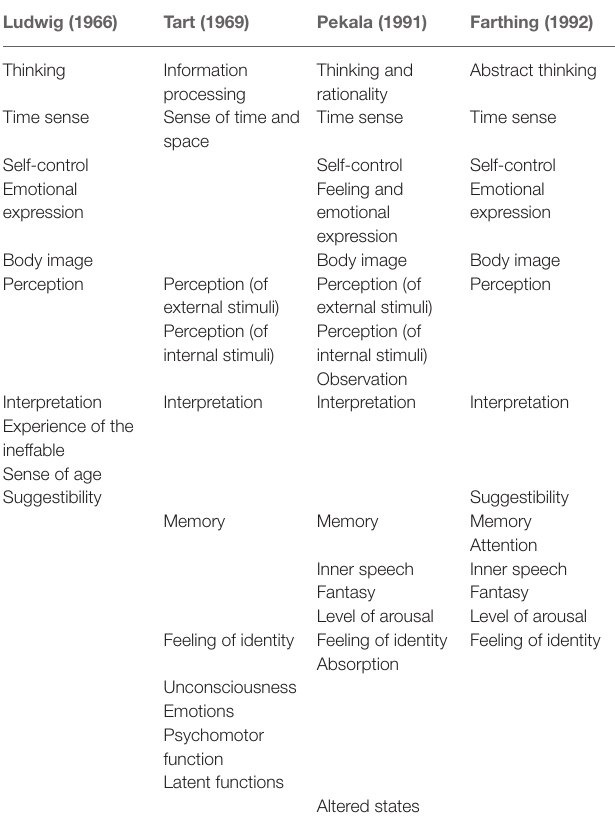
TABLE 1 | Consciousness as an assembly of psychological